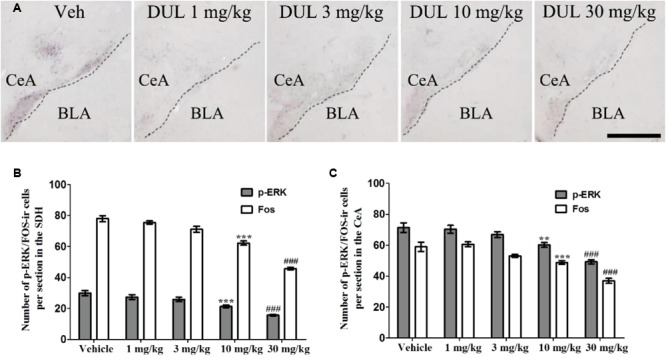
DUL dose-dependently inhibited the p-ERK and Fos expressions in the ipsilateral SDH and contralateral CeA. Representative immunostaining images showed the p-ERK expressions in the contralateral CeA after formalin injection 24 h, in different treatment groups (A). DUL dose-dependently inhibited the p-ERK and Fos expressions in the ipsilateral SDH after formalin injection 2 h (B). DUL dose-dependently inhibited the p-ERK and Fos expressions in the contralateral CeA after formalin injection 24 h (C). Scale Bar = 200 μm in A. ∗∗P < 0.01, ∗∗∗P < 0.001, DUL 10 mg/kg group compared with vehicle group; ###P < 0.001, DUL 30 mg/kg group compared with vehicle group; one-way ANOVA, Turkey’s post hoc test, n = 18 sections in each group.